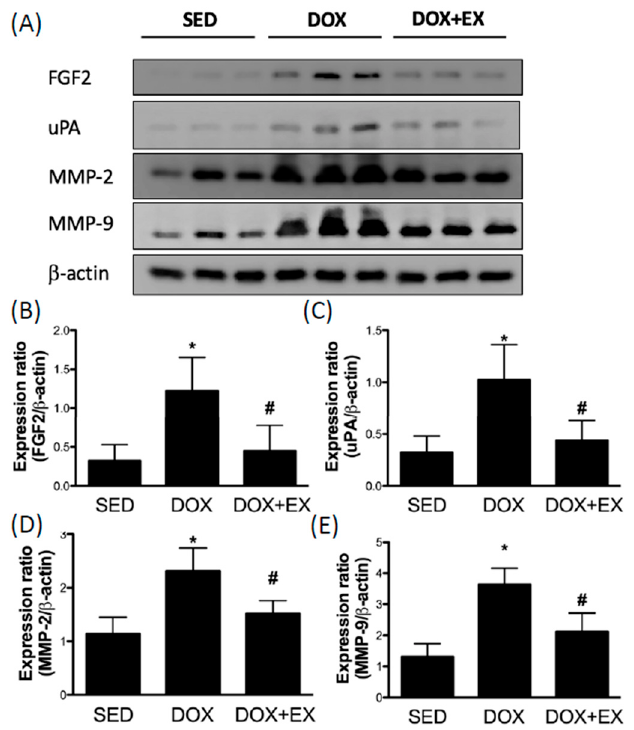
Figure 3. The effect of treadmill exercise on the DOX-triggered upregulation of cardiac remodeling-related factors Representatives of Western blot ( A ) and the densitometric analysis of FGF2 ( B ), uPA ( C ), MMP-2 ( D ) and MMP-9 ( E ). * p < 0.05 compared to the SED group. # p < 0.05 compared to the DOX group. Detailed information about Figure 3A can be found at Figure S3.